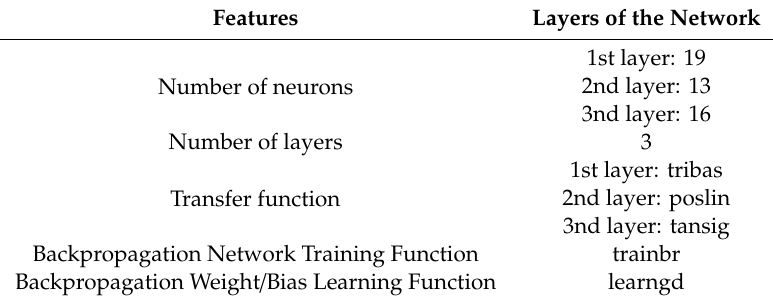
Table 11. Structure of hidden layers of ANN-PSO algorithm to estimate